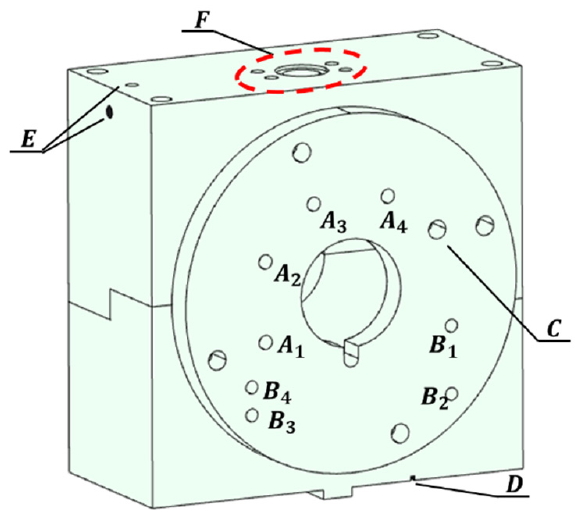
decouple the x – y directions [24].